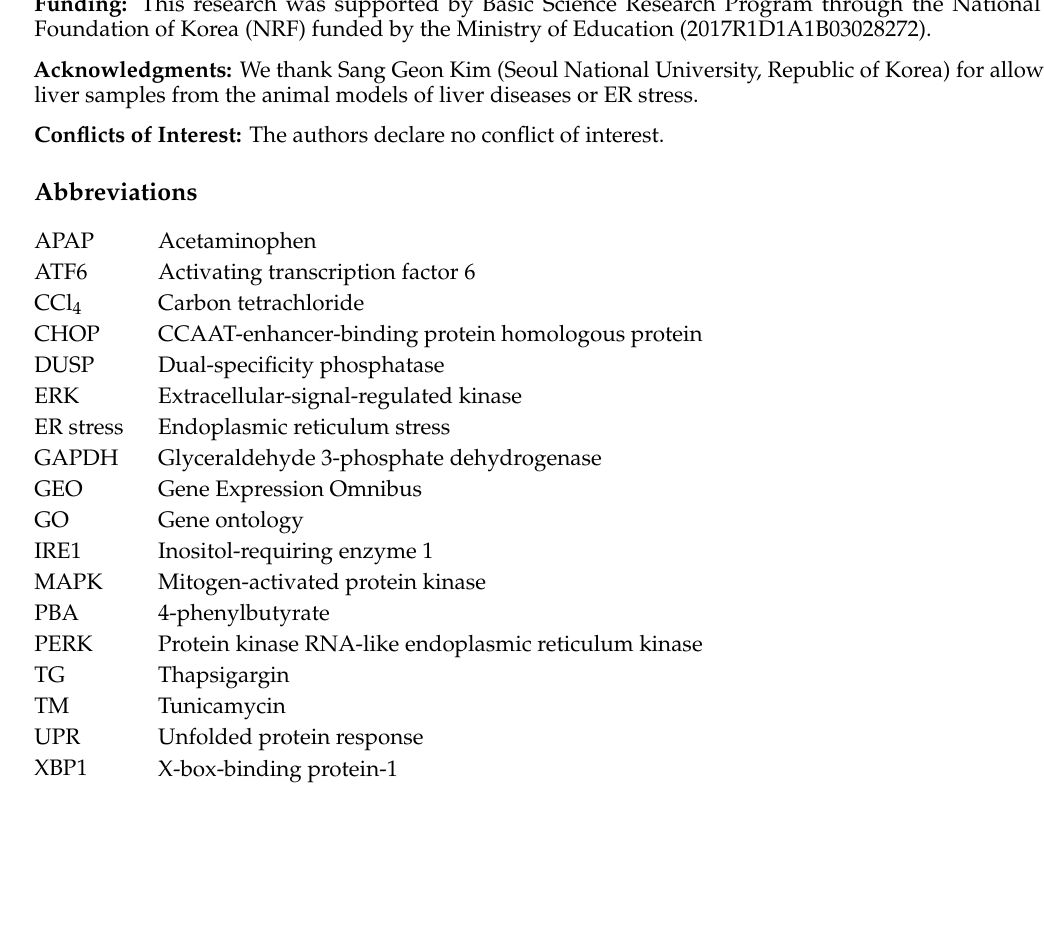
Table S1. The primer sequences for qRT-PCR